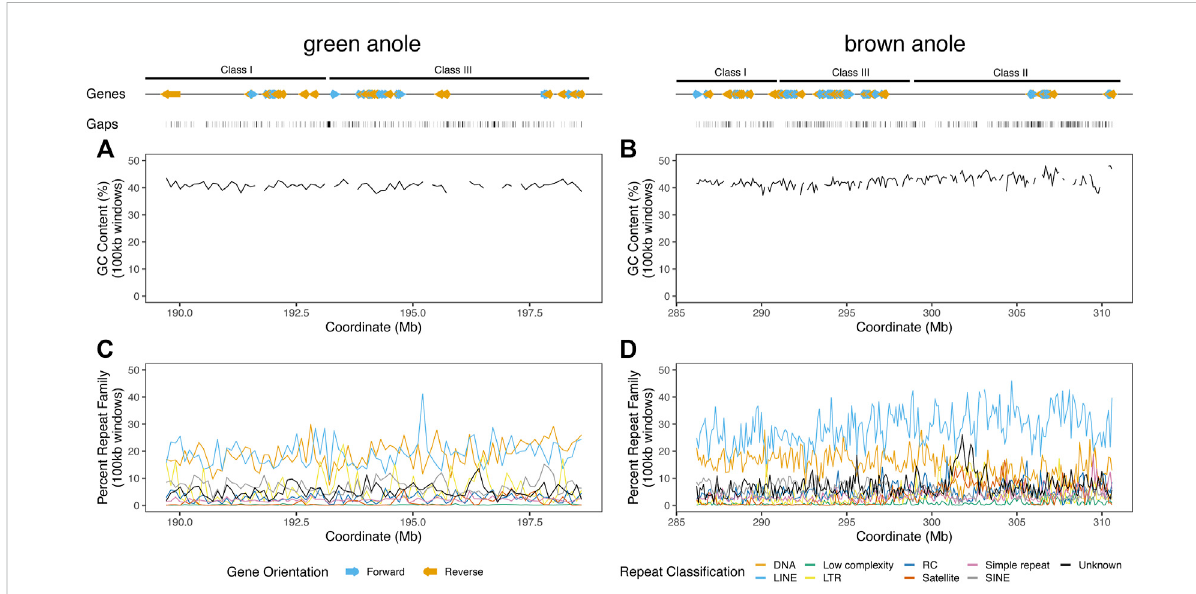
FIGURE 5 Landscapes of genomic features within the well-assembled portions of the core MHC regions in the green and brown anole genomes. GC percentage across non-overlapping 100 kb windows of the MHC regions of the (A) green and (B) brown anole genomes. Abundances of repeat elementsinthe (C) greenand (D) brownanoleMHCregions.Repeatabundanceswerequanti fi edasthepercentageofagivenrepeatclassi fi cationin non-overlapping100 kbwindows.Whentheproportionofgaps(i.e.,Ns)wasgreaterthan10%inawindow,wedidnotcalculateGCpercentage to avoid large fl uctuations in GC content that are due to large amounts of missing data in a window. Protein-coding genes annotated (color and orientation aligns with gene orientation) and assembly gaps are displayed as tracks above the distributions of GC and repeat content.